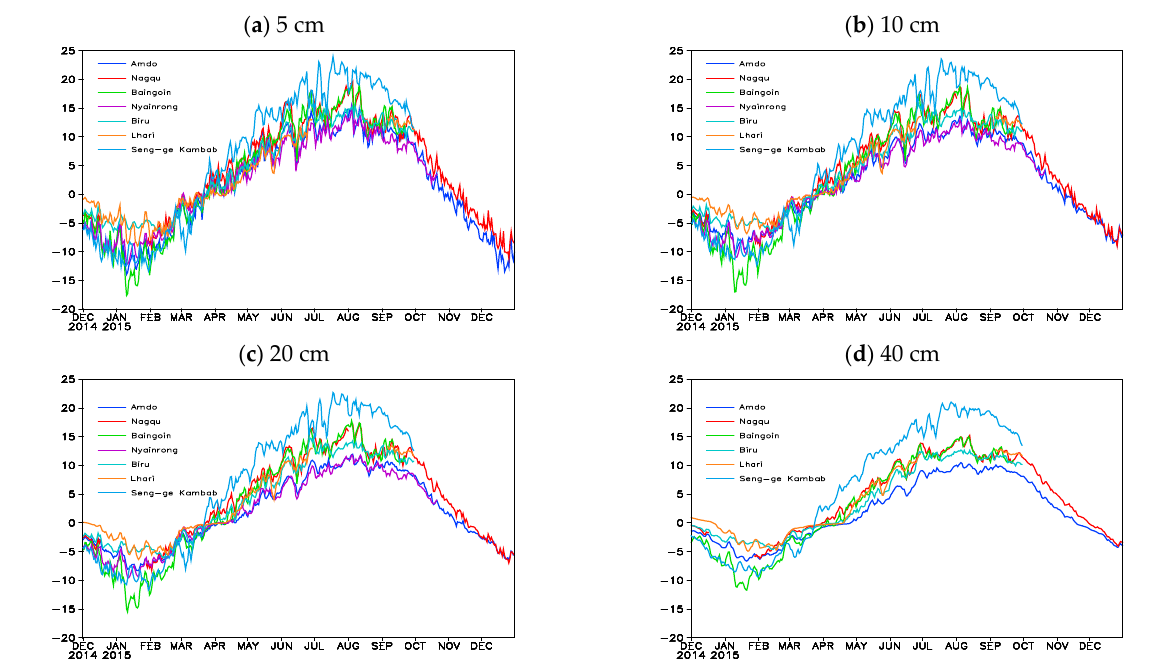
Figure 6. Time series of daily mean soil temperature at different depths for the seven observational sites (unit: °C).